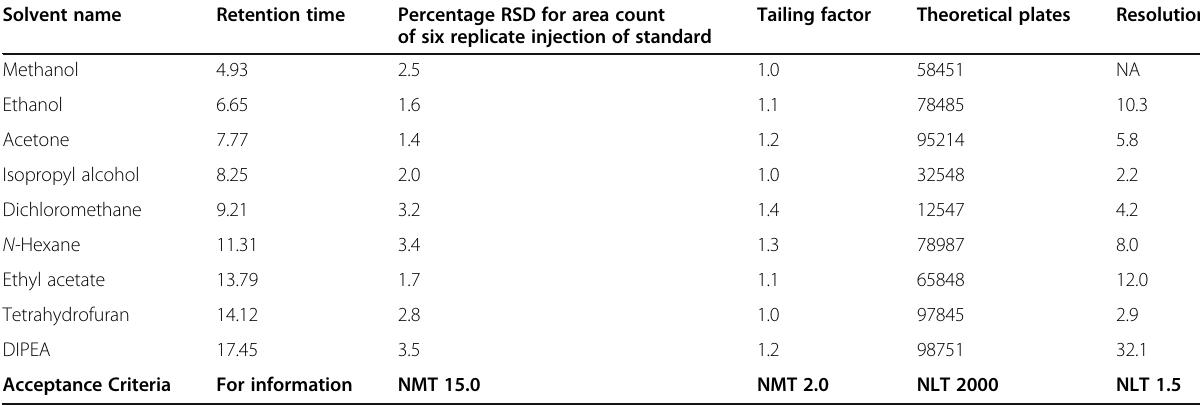
Table 4 Results of system suitability